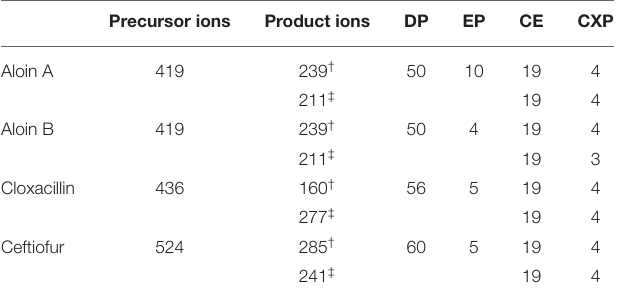
TABLE 2 | Multiple reactions monitoring (MRM) for aloin A, aloin B, cloxacillin, and ceftiofur detected in milk. Precursor